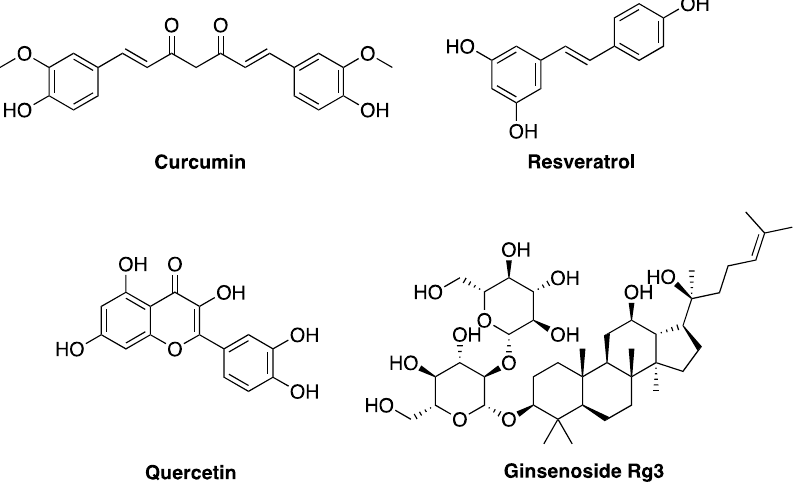
Figure 4. Chemical structures of curcumin, resveratrol, quercetin, and ginsenoside Rg3, the most promising natural compounds discussed in the review.